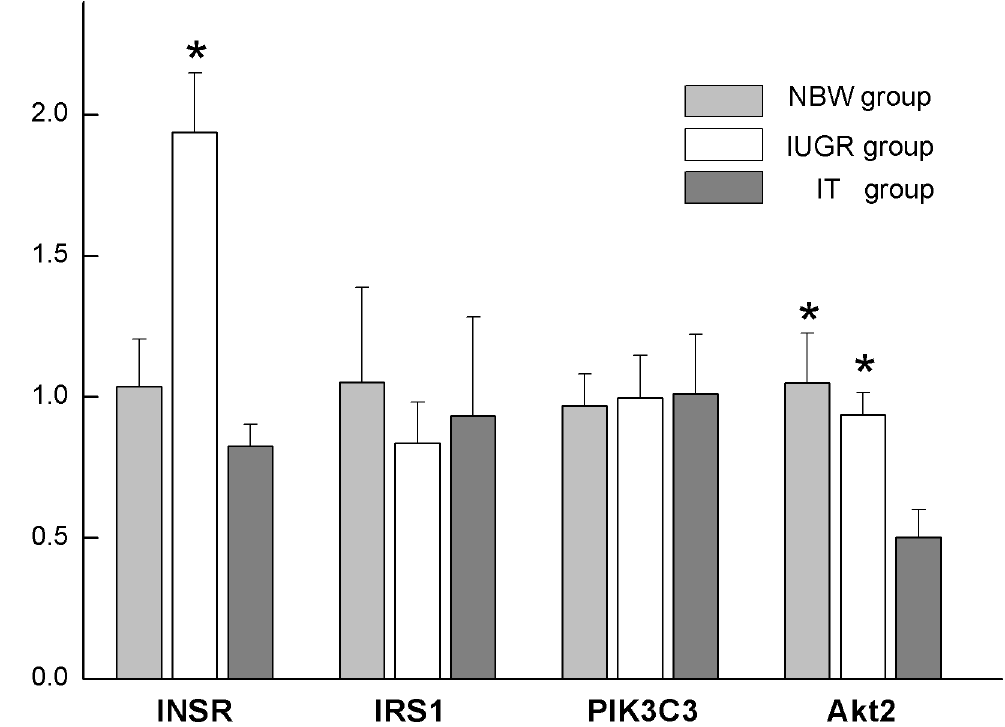
Fig 1. mRNA expression for INSR, IRS1, PIK3C3, and Akt2 was normalized using GAPDH as the control. Data are expressed as mean ± SEM, n = 6. SEM, standard error of mean. * indicates a significant difference from control group ( P < 0.05). NBW, piglets with normal birth weight that were fed with basic milk diets; IUGR: piglets with intrauterine growth retardation that were fed with basic milk diets; IT, piglets with intrauterine growth retardation that were fed with diets supplemented with 0.1% tributyrin.